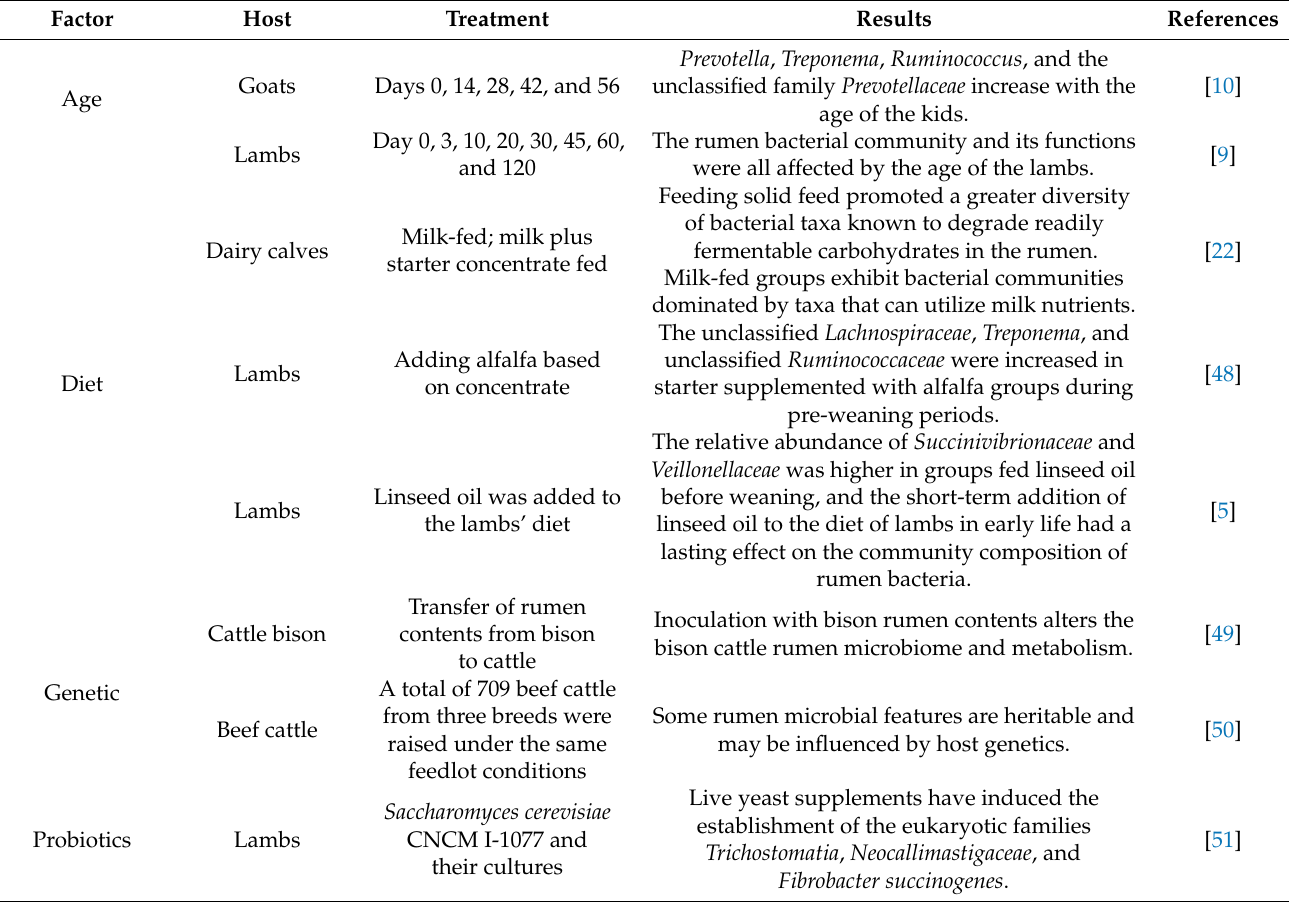
Table 1. Factors influencing the rumen